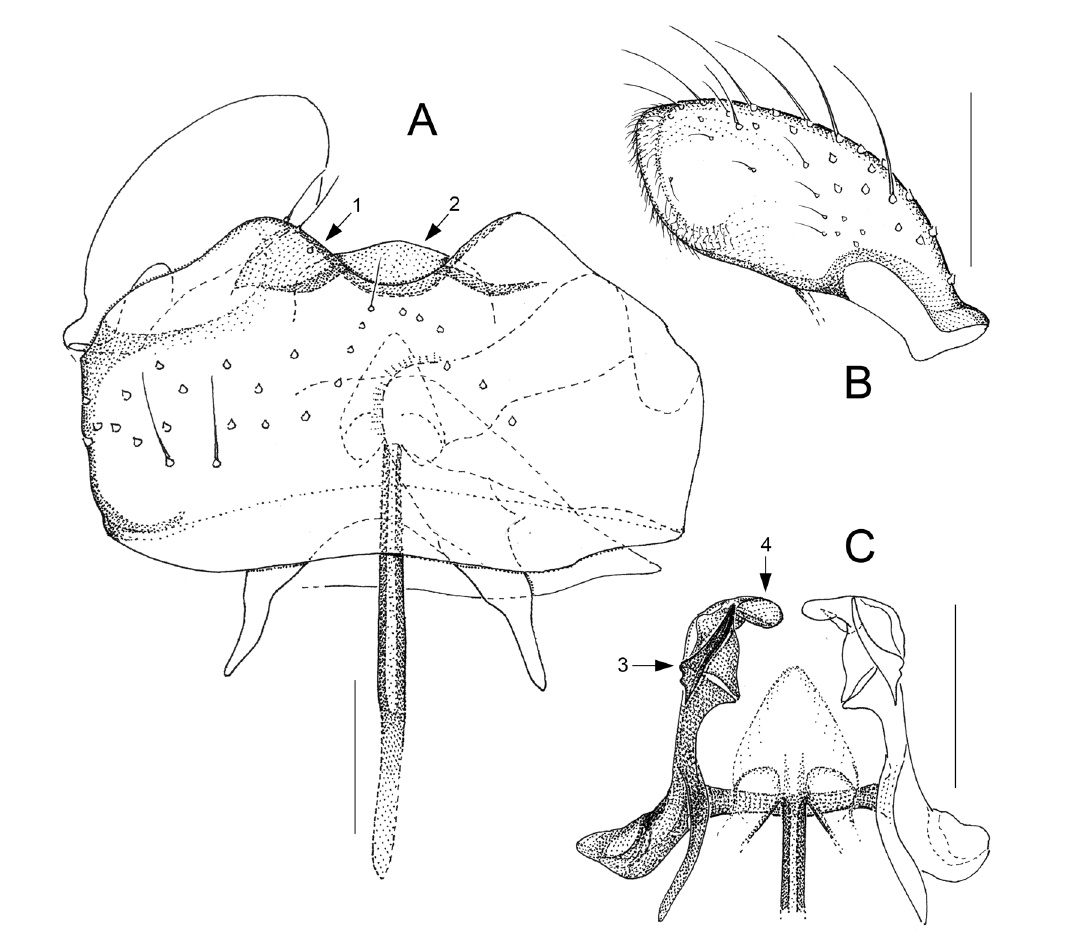
Fig. 8. Glemparon kaikoura sp. nov., holotype, ♂ (NZAC, no. CEC1411). A . Genitalia, ventral. B . Gonostylus, ventral. C . Apex of ejaculatory apodeme and tegmen, ventral. Scale bars = 0.05 mm. Numbered arrows indicate diagnostic characters (see